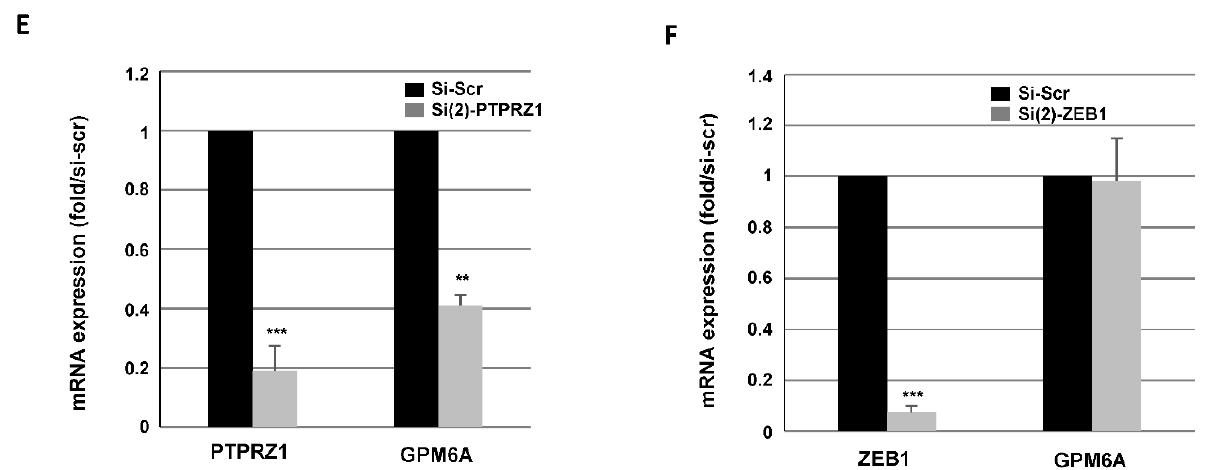
Figure 5. GPM6A and PTPRZ1 expression are correlated in GB. ( A , B ) The correlations between GPM6A mRNA expression and PTPRZ1 or ZEB1 were obtained by the co-expression analysis in Gliovis [20] using the TCGA database. Values correspond to the Pearson correlation coefficient and its associated p -value. ( C , D ) mRNA expression of ( C ) PTPRZ1 and ( D ) ZEB1 was analyzed by real-time PCR in each of the 14 primary cultures of GBSC isolated from 14 patient samples. GAPDH was used for normalization. Results are presented as means of the relative expression (compared to GSC04 which has the lowest expression) for each group (highly or low invasive). Quantifications between the two groups are presented as means ± SD. *** p < 0.001; ** 0.001 < p < 0.01; * 0.01 < p < 0.05. ( E , F ) Primary neurospheres were transfected with a specific PTPRZ1 siRNA (si(2)-PTPRZ1), a specific ZEB1 siRNA (si(2)-ZEB1), or a scramble control (si-Scr). PTPRZ1, GPM6A, and ZEB1 mRNA expression was analyzed by real-time PCR. GAPDH was used for normalization. Quantifications of 3 experiments are presented as means ± SD. *** p < 0.001; ** 0.001 < p < 0.01; * 0.01 < p <